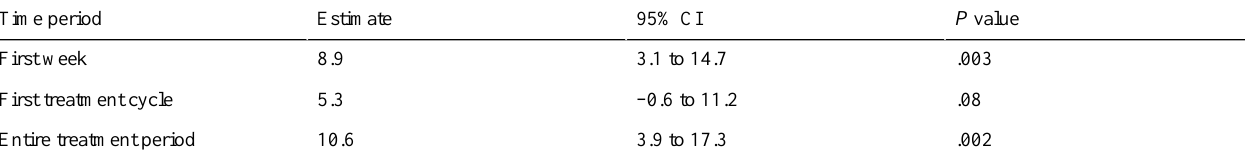
Table 3. Summary score adjusted mean differences between intervention and control groups.